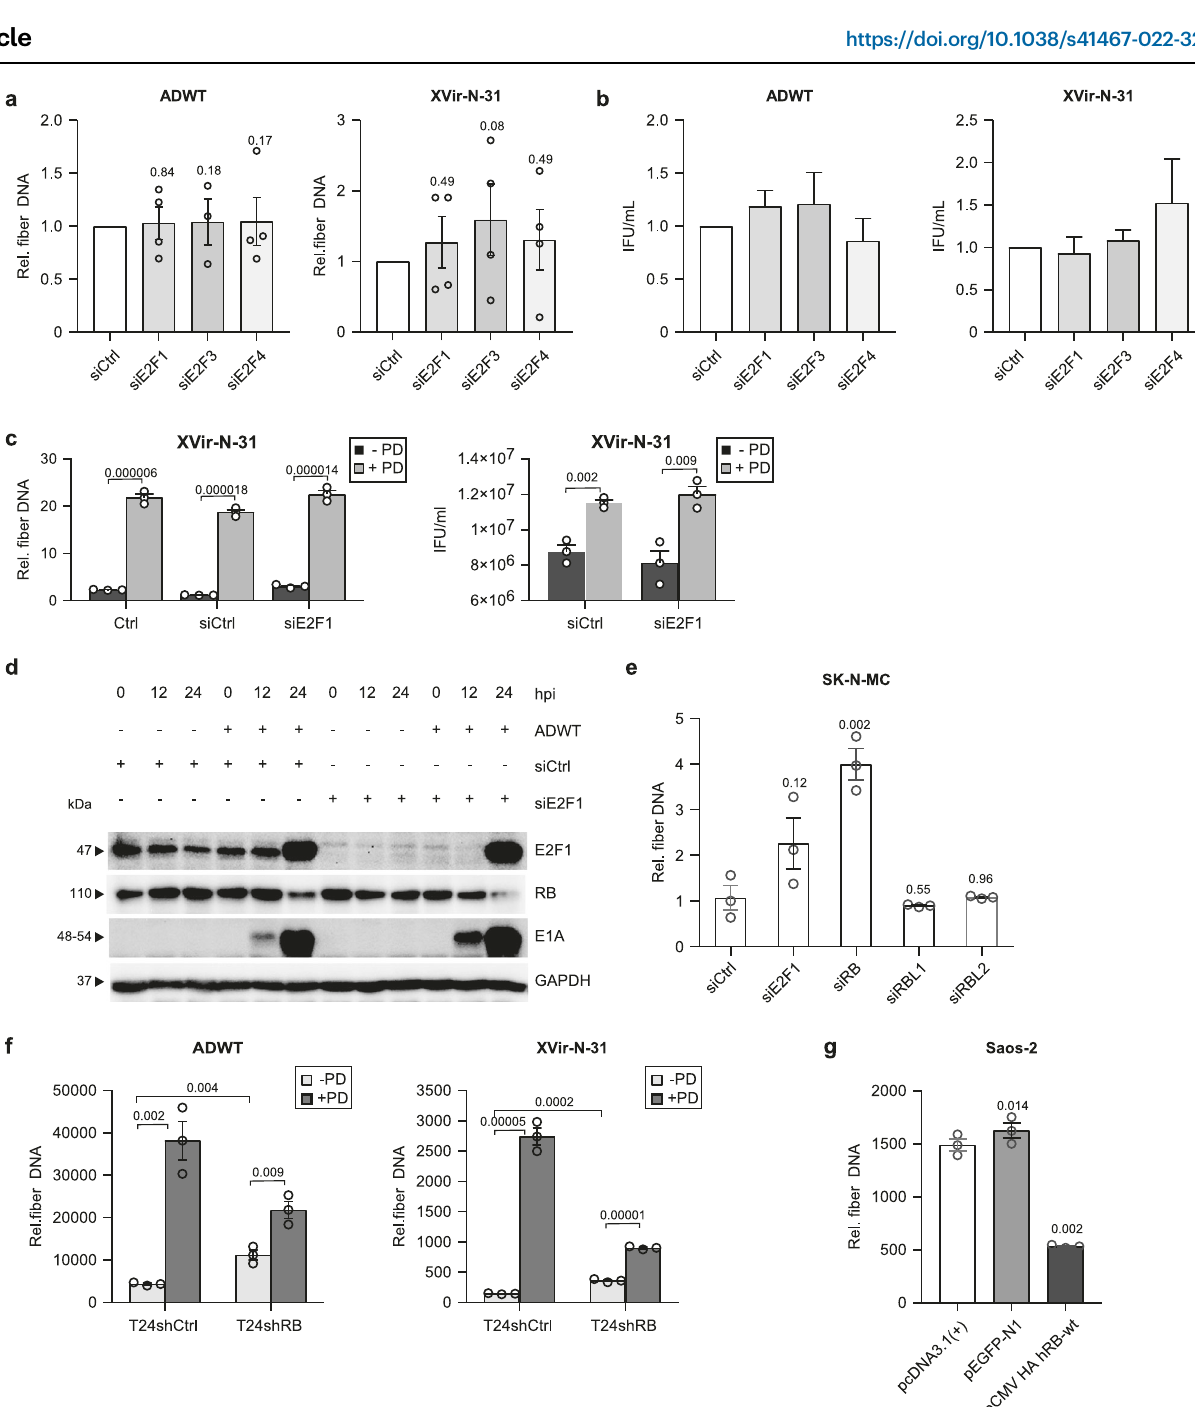
and infected with the XVir-N-31 (MOI 20). Viral replication was analyzed at 48hpi. n =3. f RB-negative T24shRB1 cells and scrambled control T24shCtrl cells were treated with Palbociclib (1 µ M) and infected with MOI 50 of the indicated viruses. Viral genome replication was analyzed at 24 hpi. g RB-negative Saos-2 cells were transfected withindicated plasmids and infected with adenovirus ADWT (MOI20). Viral genome replication was analyzed at 24hpi. n =3. All viral genome replication analyses were performedby qPCR to amplify viral fi ber DNA. Data are represented asrelative fi berDNAatindicatedtimepointscomparedto fi berDNAat4hpiasthe baseline(mean±SD).SDstandarddeviation,SEstandarderror,MOImultiplicityof infection,hpihourspost-infection.Thestatisticalsigni fi cancewasdeterminedbya two-sided Student ’ s t -test; n: number of biologically independent samples. Source data are provided as a Source Data fi